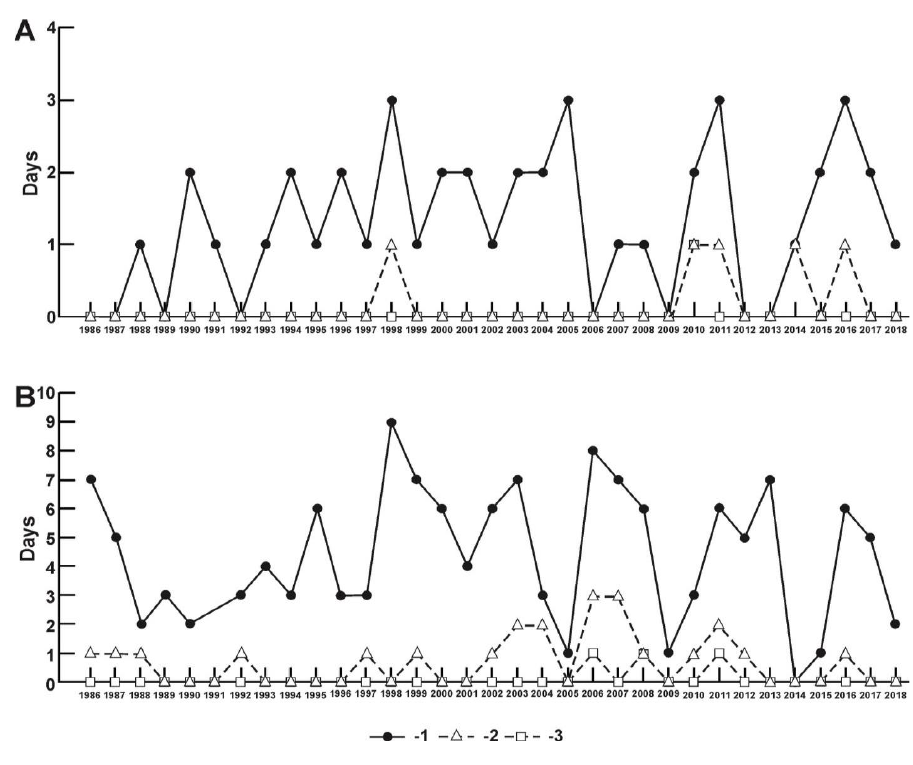
Figure 8. Number of days with rainfall of different intensities in ( A ) May and ( B ) August–September for 1986 – 2018: 1: >10 mm; 2: >30 mm; 3: >50 mm.